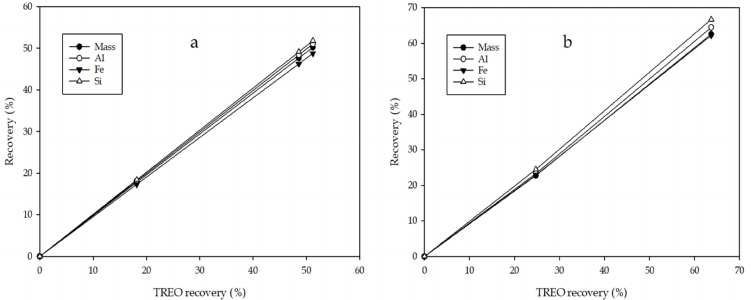
Figure 5. TREO–mass and selected gangue species recoveries relationship in concentrates obtained at ( a ) pH 9 and ( b ) pH 10.5.